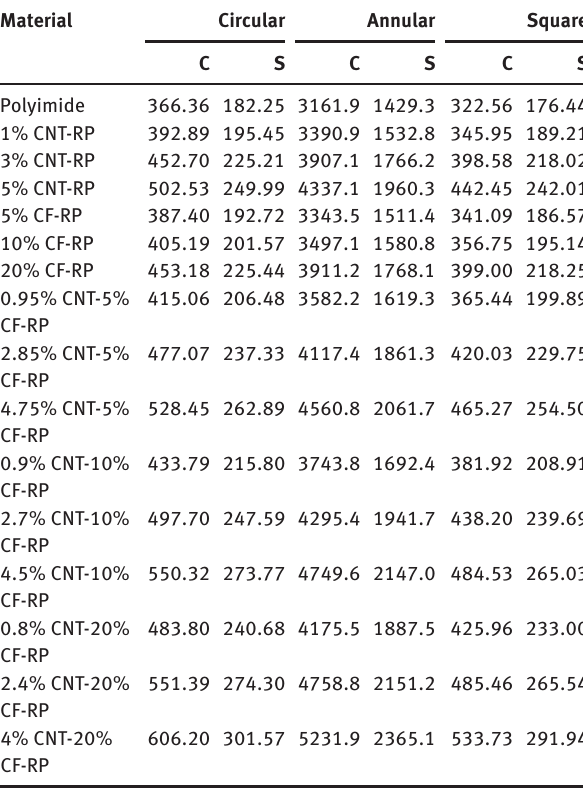
Figure 6: Forced vibration behavior of clamped annular